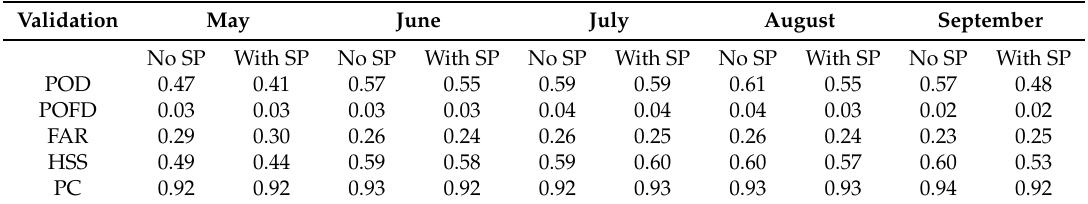
Table 6. Comparison of scene based trained models with a ratio of 1:3 without and with the use of static predictors (SP).